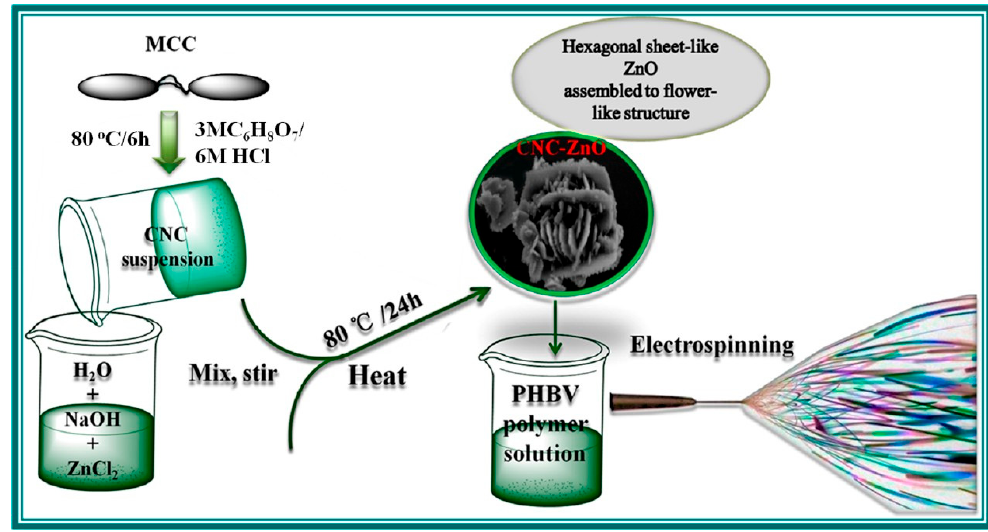
Figure 6. Schematic representation of the CNC-ZnO nanohybrids preparation procedure and the poly(3-hydroxybutyrate-co-3-hydroxyvalerate) (PHBV)/CNC-ZnO electrospinning process [88].